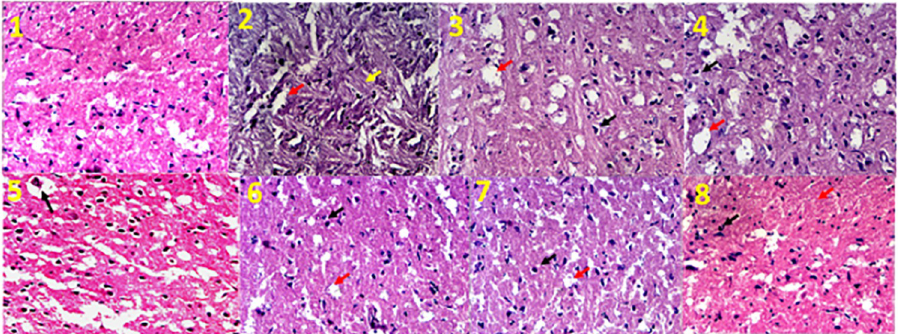
Fig 11. (Slide 1–8): H & E-stained sections of cortex of diabetic rats treated with Saffron and Chamomile at 400x magnification (Light microscope). (1): Control group, (2): Diabetic control with dark staining showed neuronal damages and shrinkages, vacuolation (red arrow) and tangle formation (yellow arrow), (3–5): Saf ME, Cham ME and Saf+Cham ME showed protection against tangle formation but vacuolation (red arrow) and enlargement in outer layer of cells (black arrow) is visible, (6–8) Saf WD, Cham WD and Saf+Cham ME showed the reduced enlargement in outer layers (black arrows) and reduced vacuolation (red